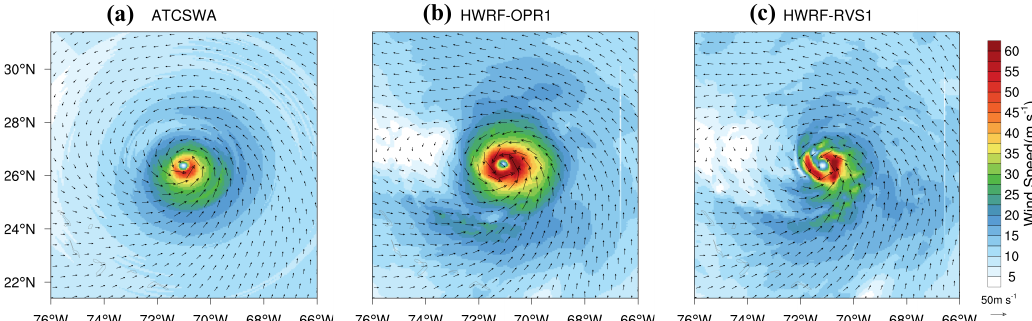
Figure 7. Vortex structure of Hurricane Joaquin at 1800 UTC 03 October 2015 as revealed by wind speed (shaded; unit: m s − 1 ) and vectors at 10-m height from ( a ) Aircraft-based Tropical Cyclone Surface Wind Analysis (ATCSWA), ( b ) HWRF-OPR1 and ( c )